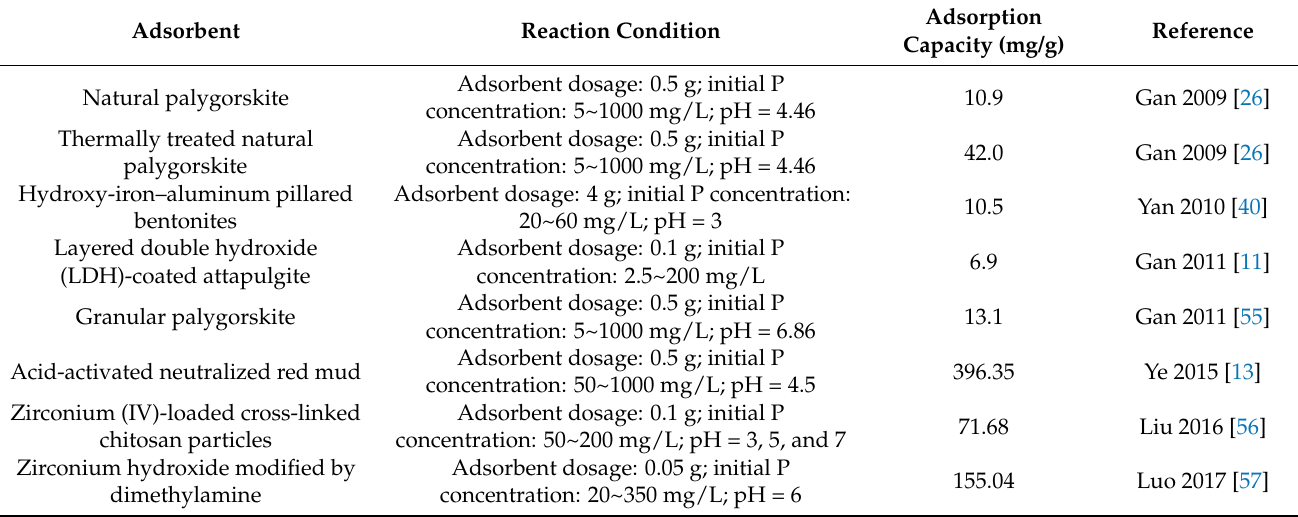
Table 5. Thermodynamic parameters of phosphate sorption on MTPG.